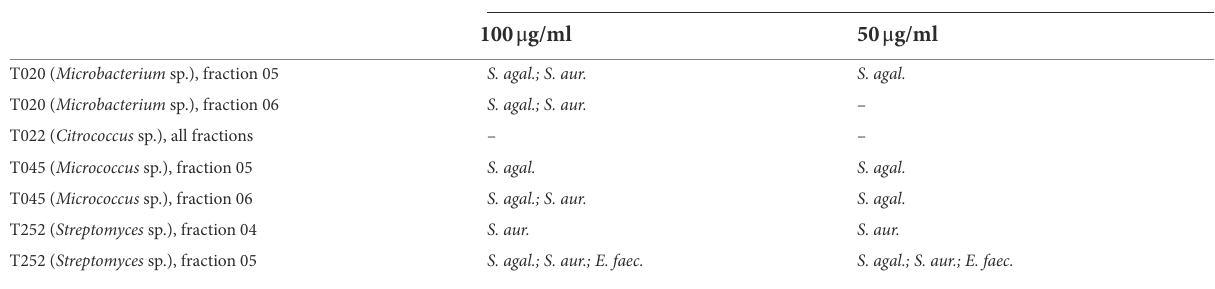
TABLE 4 Results of the anti-bacterial screening for the fractionated resin extracts.